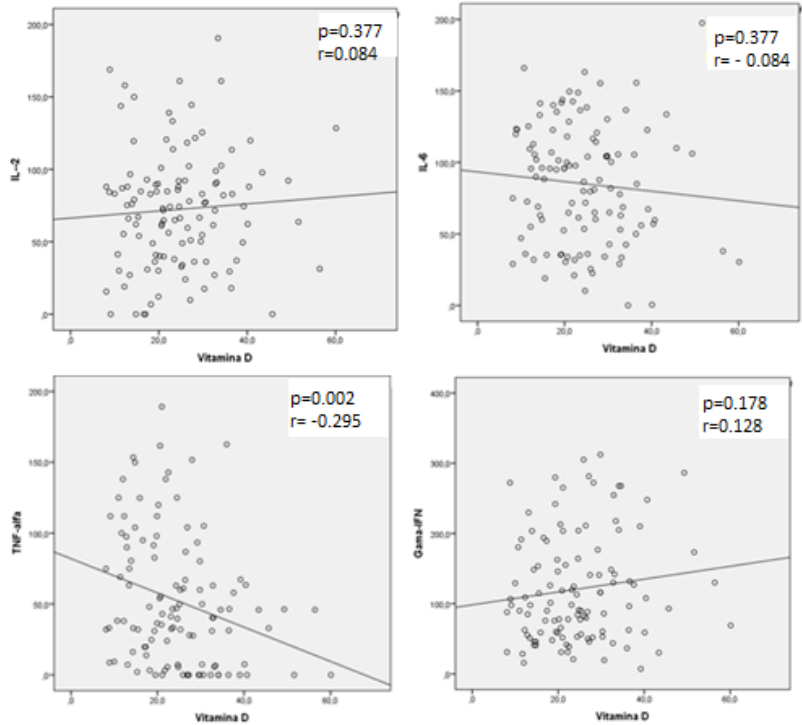
Figure 2. Correlation between serum levels of vitamin D and pro-inflammatory cytokines (IL-2, IL-6, TNF- α and IFN- γ ) in HAM/TSP patients.